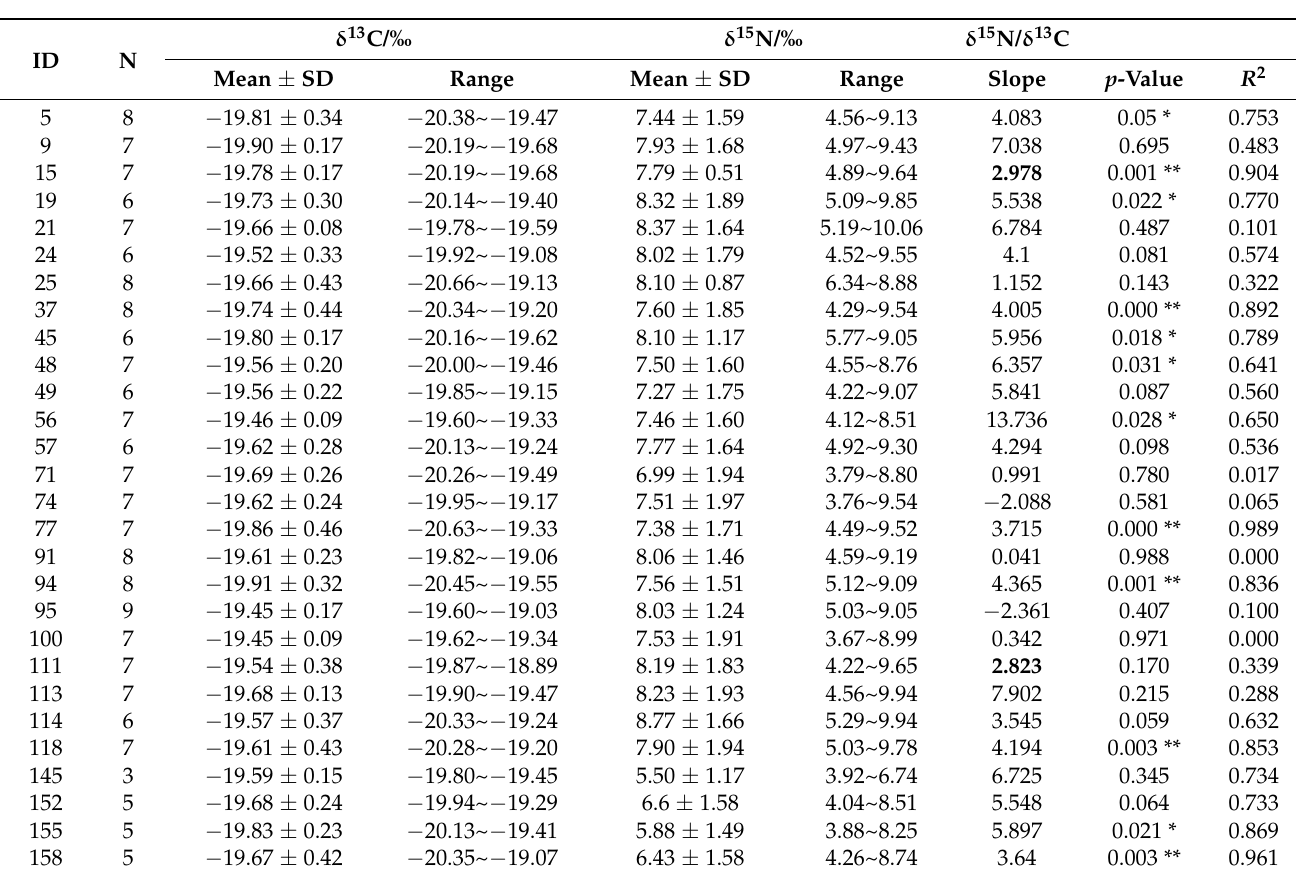
A total of 297 segments were extracted from 40 eye lenses. δ (cid:2869)(cid:2871) C values ranged from − 21.04‰ to − 18.89‰, and the δ (cid:2869)(cid:2873) N values from 3.67‰ to 12.27‰. Among them, there was a significant correlation between δ (cid:2869)(cid:2873) N and δ (cid:2869)(cid:2871) C values of successive segments of 19 individuals with positive correlation ( p < 0.05). Only six specimens had a value of 3 for the ratio of δ (cid:2869)(cid:2873) N to δ (cid:2869)(cid:2871) C for the series of segments (Table 3). Table 3. Details of the linear relationship between δ 15 N and δ 13 C for the sampled O. bartramii eye lenses.